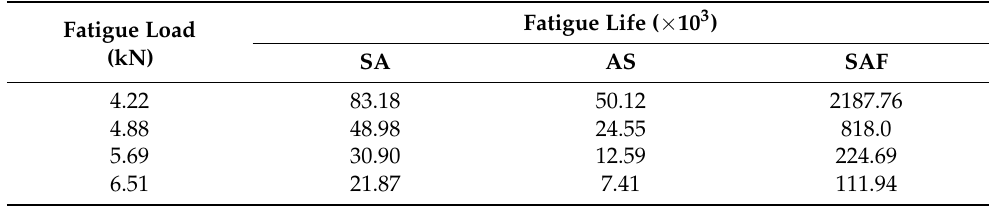
Table 4. Fatigue life comparison of single-rivet joints and two-rivet joints.